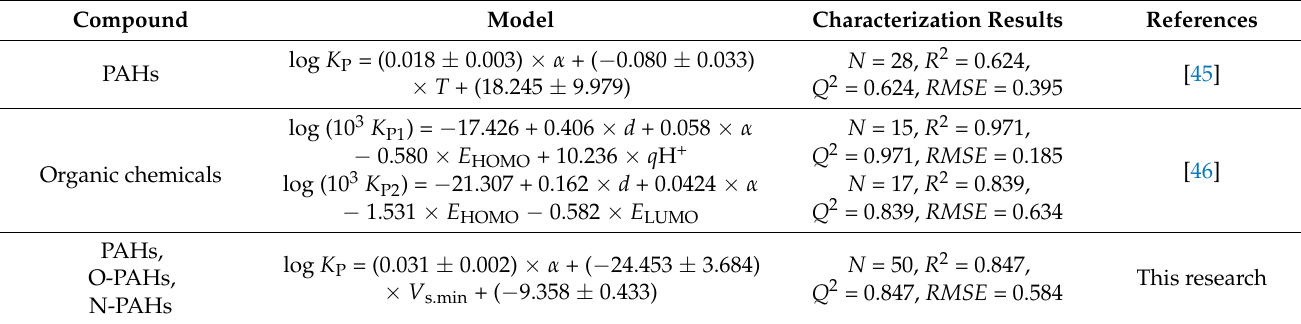
Table 4. Comparison of literature